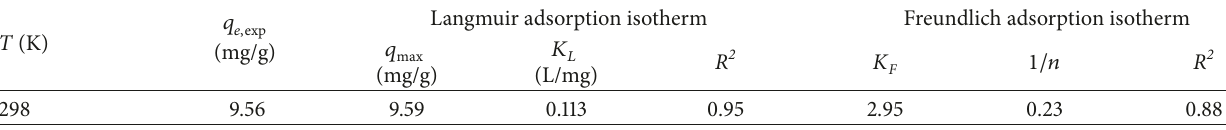
Table 1: The adsorption isothermal eq. parameters of Fe 3 O 4 /GO.